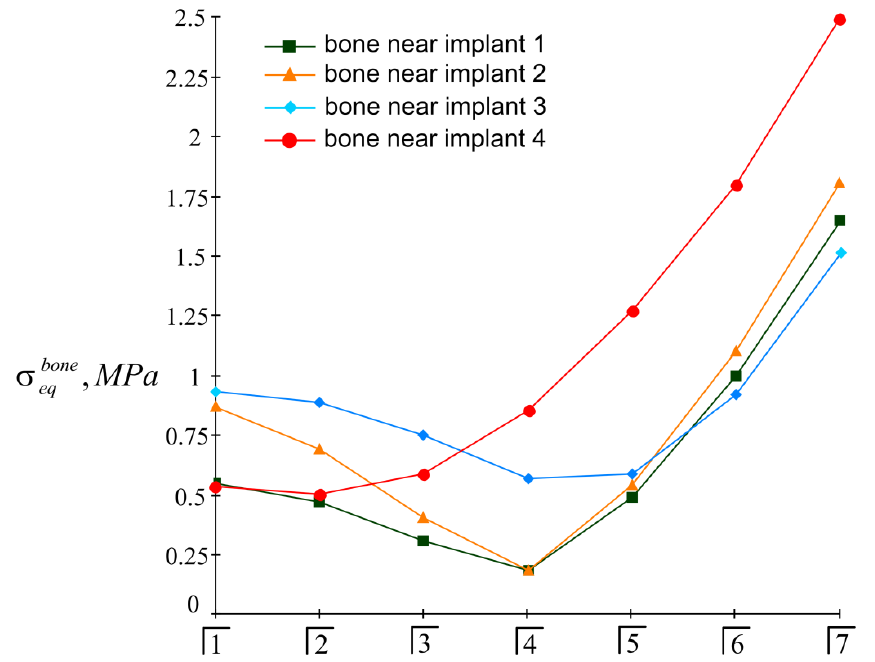
Figure 11. Comparative analysis of maximum equivalent stresses in bone tissue at different locali- zations of mastication load (the first variant of implant placement).